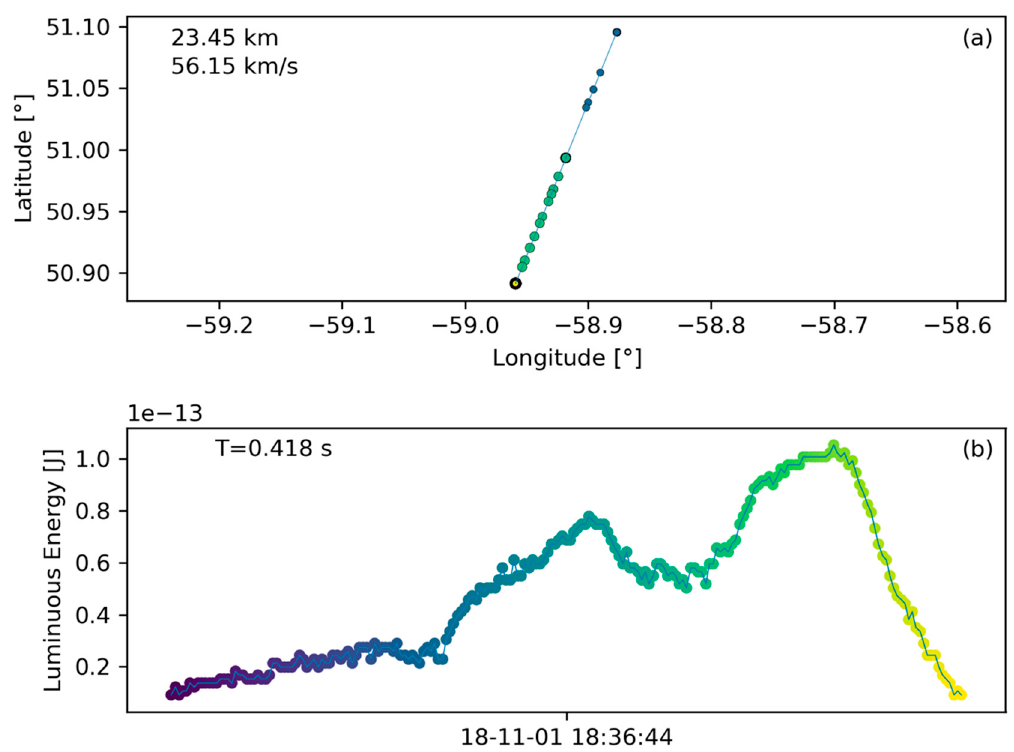
Figure 14. Unconfirmed bolide discovery corresponding to the first entry listed in Table 3. The flash occurred in a remote location over the far eastern shore of Quebec, Canada. Plot ( a ) shows ground track and plot ( b ) shows light curve.